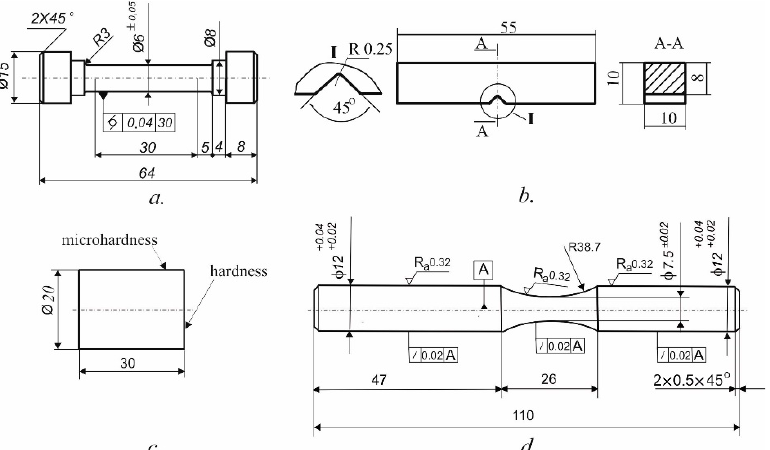
Figure 1. Geometry of the samples: ( a ) tensile test; ( b ) rotating bending fatigue test; ( c ) Charpy (impact toughness) test; ( d ) rotating cantilever bending fatigue test (the sizes are in mm).